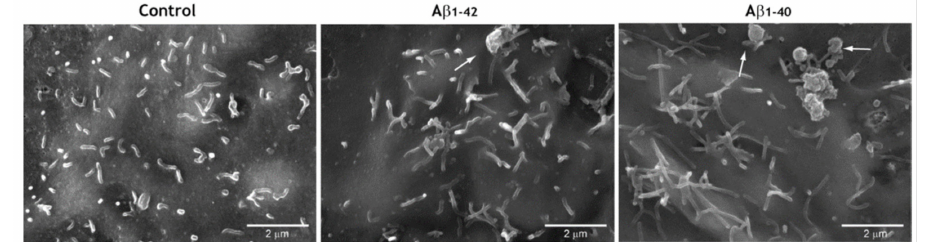
Figure 7. Binding of microvilli to A β aggregates. SEM-SE images of A β interaction with membrane protrusions formed by hCMEC/D3 cells when incubated with 1 µ M of A β 1-42 or A β 1-40 oligomers for 24 h. The images show endothelial microvilli often contacting A β aggregates (arrows).